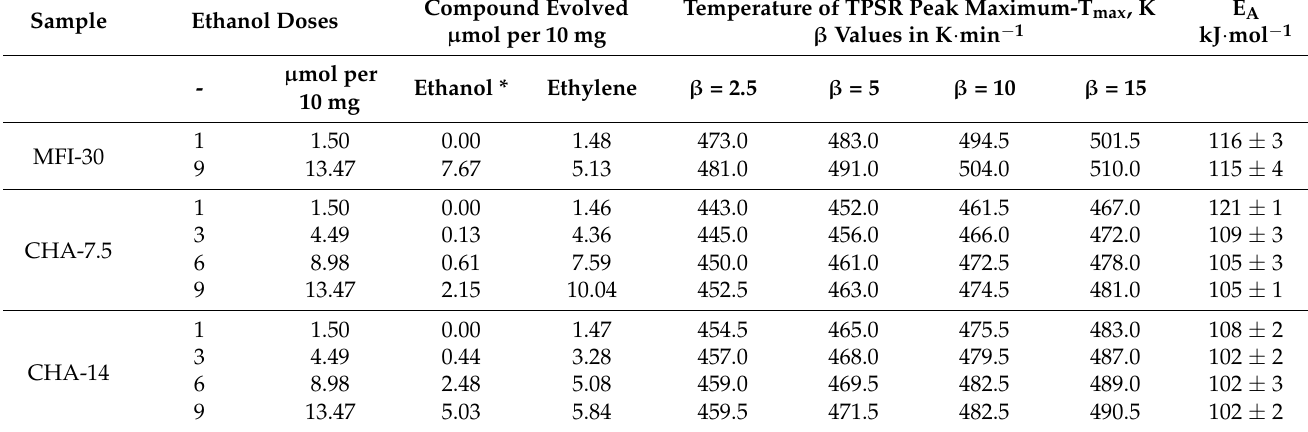
Table 3. TPSR experimental data and obtained values of activation